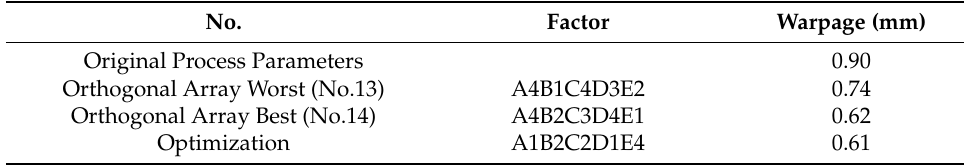
Table 8. Confirmation of Total Warpage Deformation.